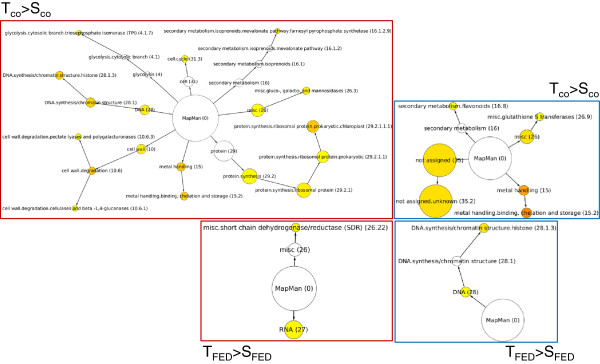
Functional enrichment analysis in the different candidate transcript groups. Over-representation of specific MapMan BINs was tested in the indicated transcript groups, in comparison to the Q. robur transcript reference set. Coloured nodes go from yellow to dark orange, representing p-values from 5E-2 to 5E-7. White notes represent MapMan BINs that are not significantly over-represented in the group. The size of a node is proportional to the number of transcripts annotated to that node.